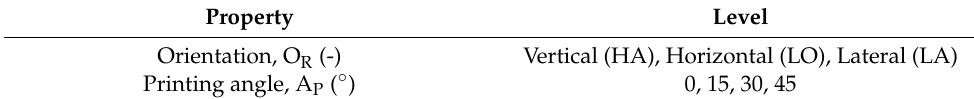
Table 1. Printing parameters used in this study.